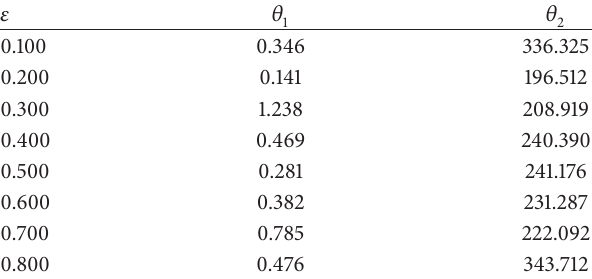
Table 4: The optimum configurations combining all the objective functions at a